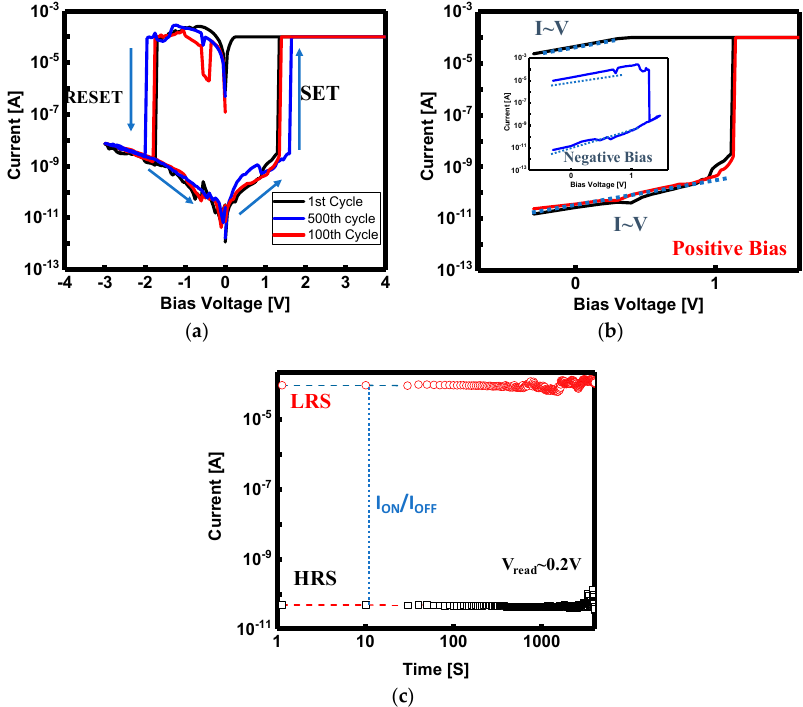
Figure 6. ( a ) Semi-logarithmic I–V characteristics of the resistive switching memory device (ReRAM) with bilayer insulator film for 100 cycles. ( b ) Double-logarithmic plot for Ag/GST/Al 2 O 3 /Pt/SiO 2 in the positive and negative sweep with Ohmic model. ( c ) Data retention characteristics of the low-resistance state (LRS) and high-resistance state (HRS) under continuous readout voltages for the as-fabricated ReRAM